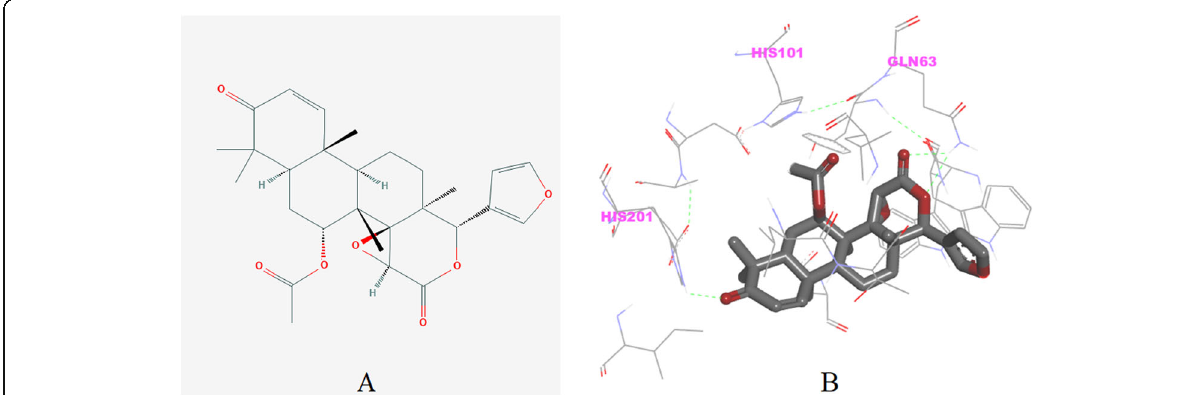
Fig. 1 Molecular docking interaction pattern of gedunin with the active site of HPA (PDB ID: 1HNY) generated using AutoDock Tools 4.2 platform ( a ) 2D structure of gedunin (PubChem CID: 12004512) ( b ) 3D docking representation of gedunin in the binding pocket showing the hydrogen bond